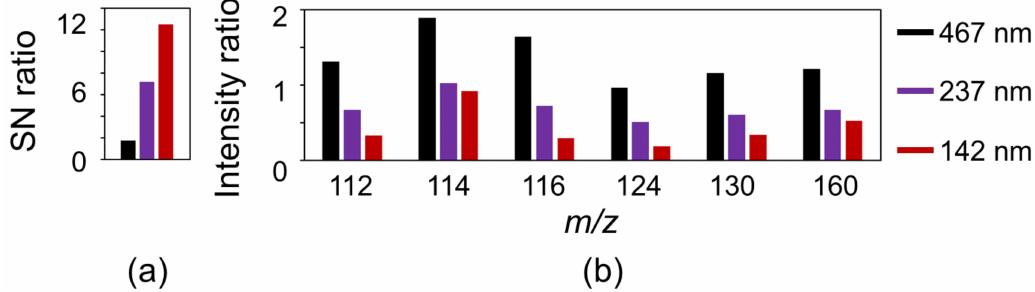
Figure 8. ( a ) Signal-to-noise (SN) ratios of arginine ( m / z = 175) and ( b ) intensity ratios of fragment ions to arginine as a function of the wall-to-wall distance of the